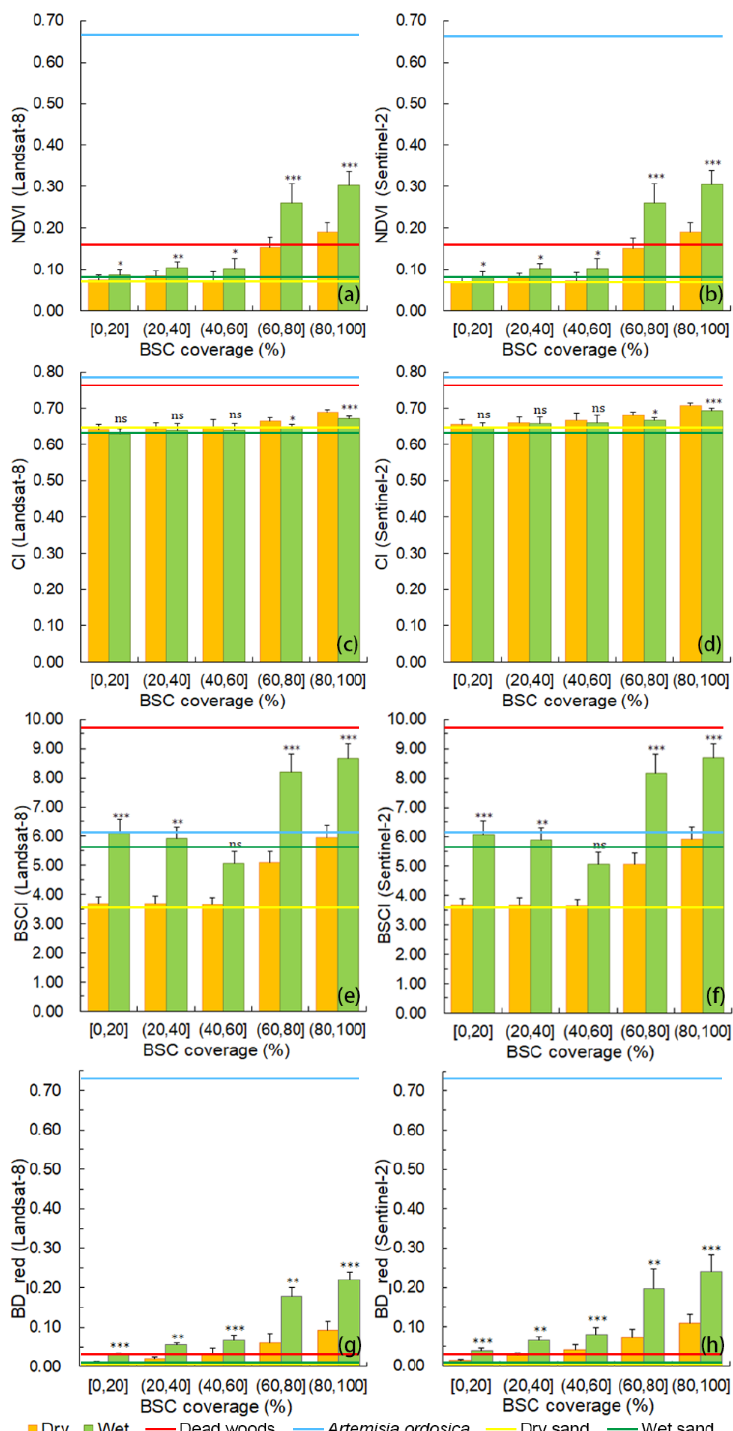
Figure 8. Normalized difference vegetation index (NDVI), crust index (CI), biological soil crust index (BSCI), and the band depth after continuum removal in the red band (BD_red) values of dry and wet biological soil crust (BSC) with different coverage levels in type C plots. ( a ) NDVI values calculated using Landsat-8 bands; ( b ) NDVI values calculated using Sentinel-2 bands; ( c ) CI values calculated